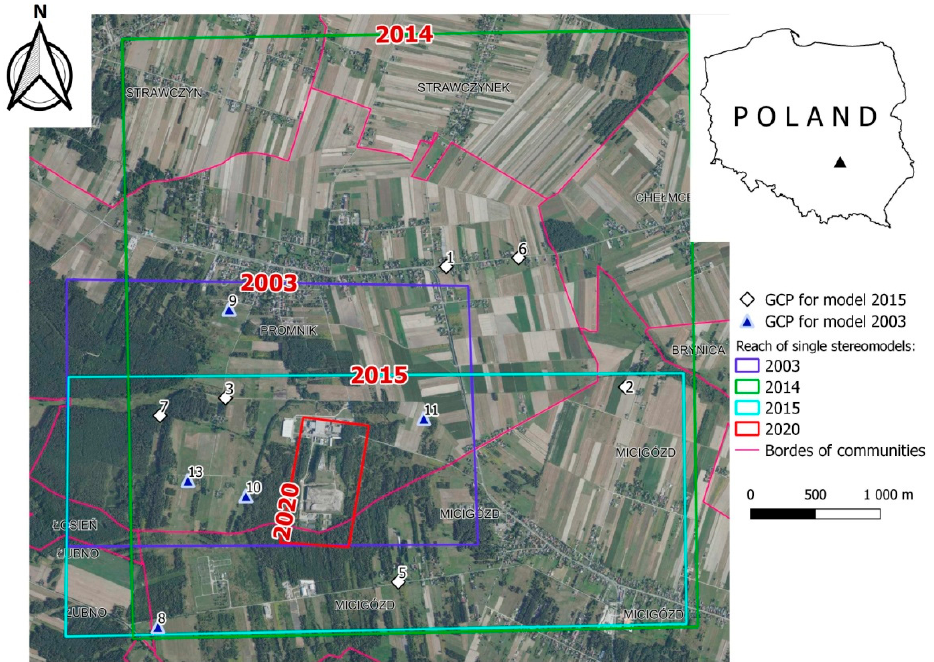
Figure 1. Location of the landfill in Promnik and the reach of the stereomodels created from used aerial images. Base orthophoto from geoportal.gov.pl (accessed on 14 November 2022).